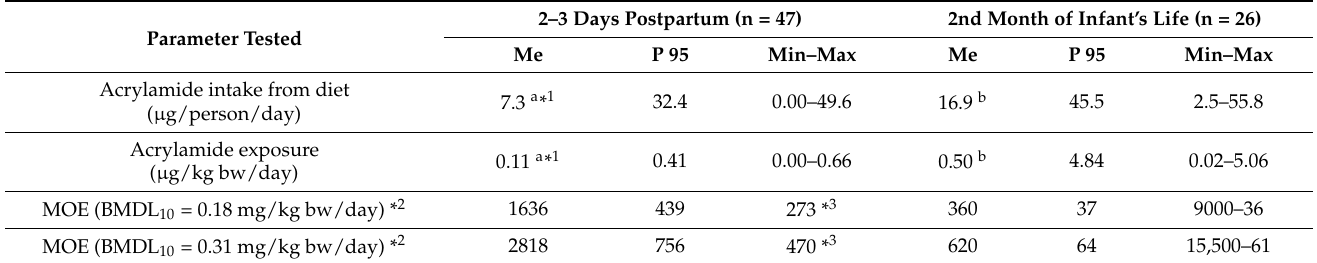
Table 4. Estimated exposure of breastfeeding women to dietary acrylamide and margins of exposure (MOE). Parameter